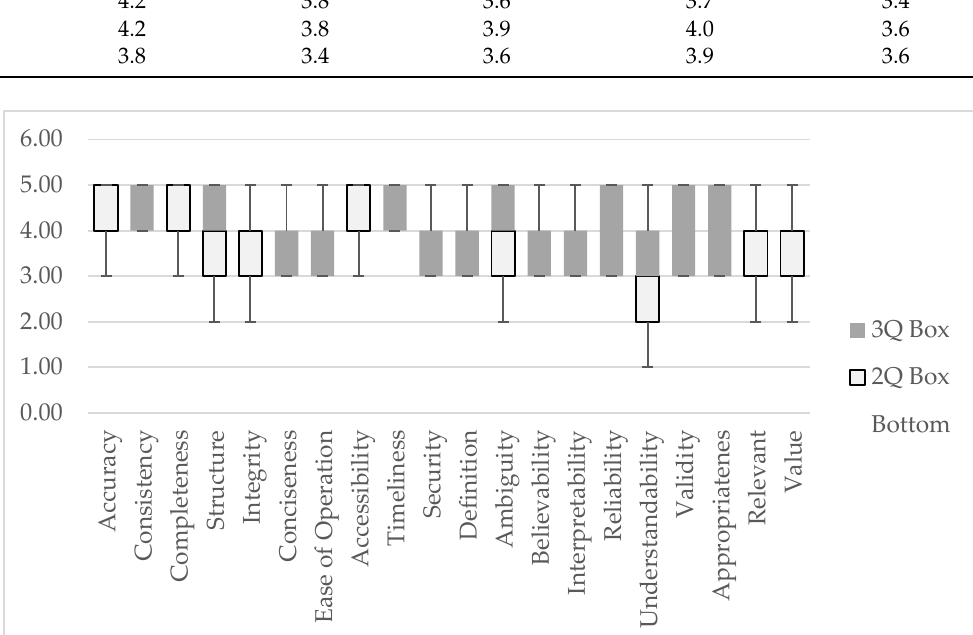
Figure 3. Semiotic levels and the data-information-knowledge hierarchy.